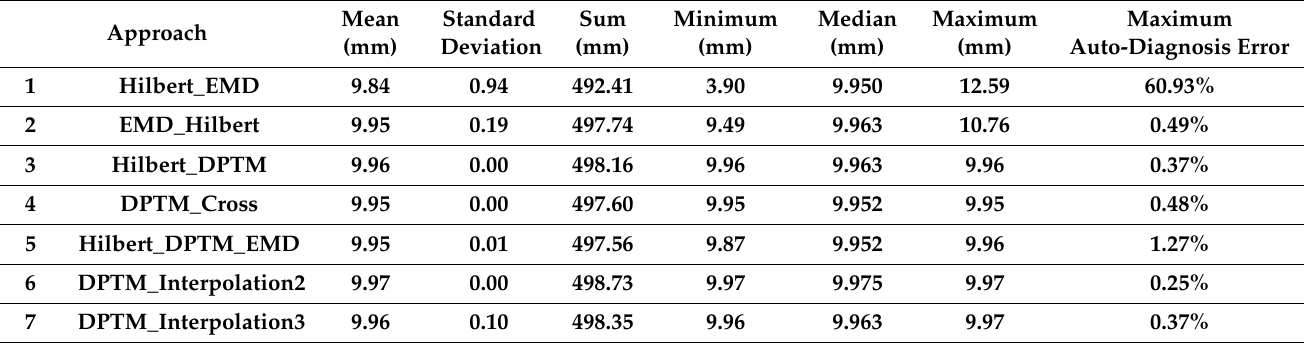
Figure 14. Results acquired on a 304SS plate using different approaches listed in Table 1. Table 1. Comparison of results acquired on a steel plate using different approaches.